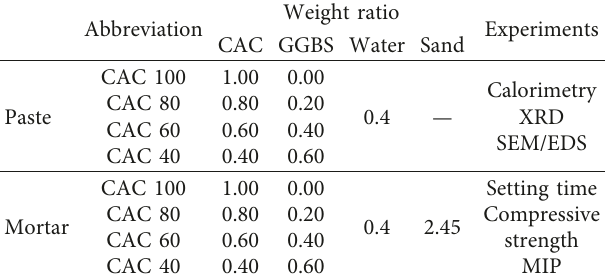
Table 2: Mix proportions for experimental works.